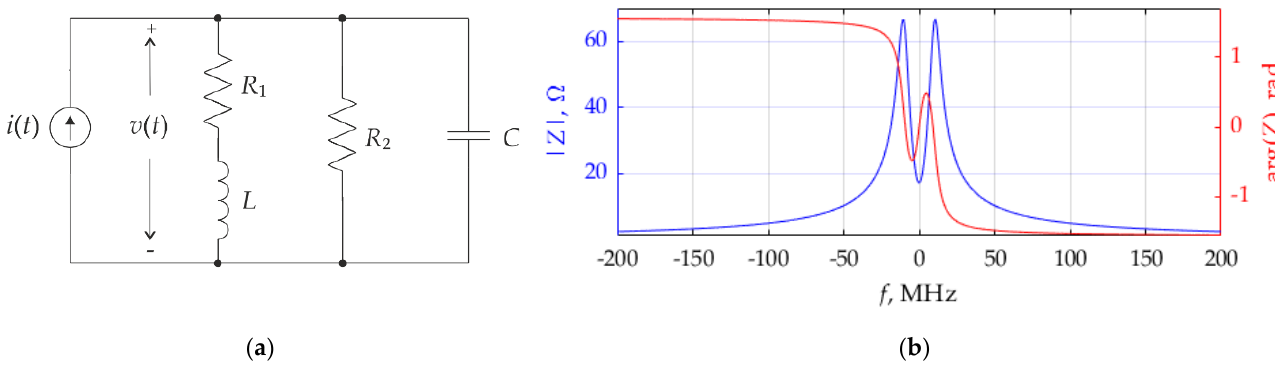
Figure 1. Resonant circuit with feeding current source ( a ) and the frequency characteristic of its input impedance as impedance module and phase versus the excitation current frequency ( b ).